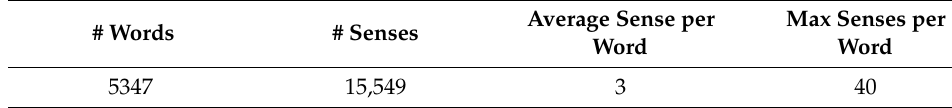
Table 1. The benchmark statistics.